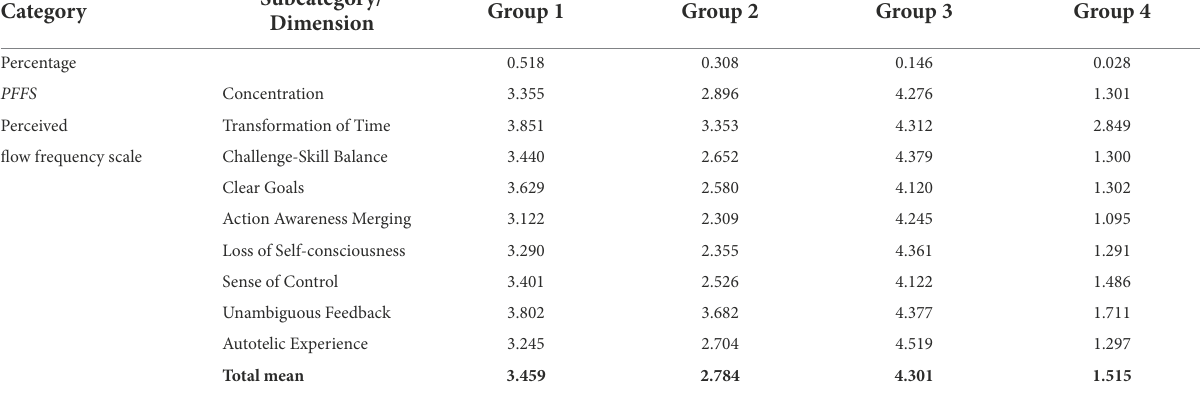
TABLE 6 Profile of the Four-Group LCFA Model of